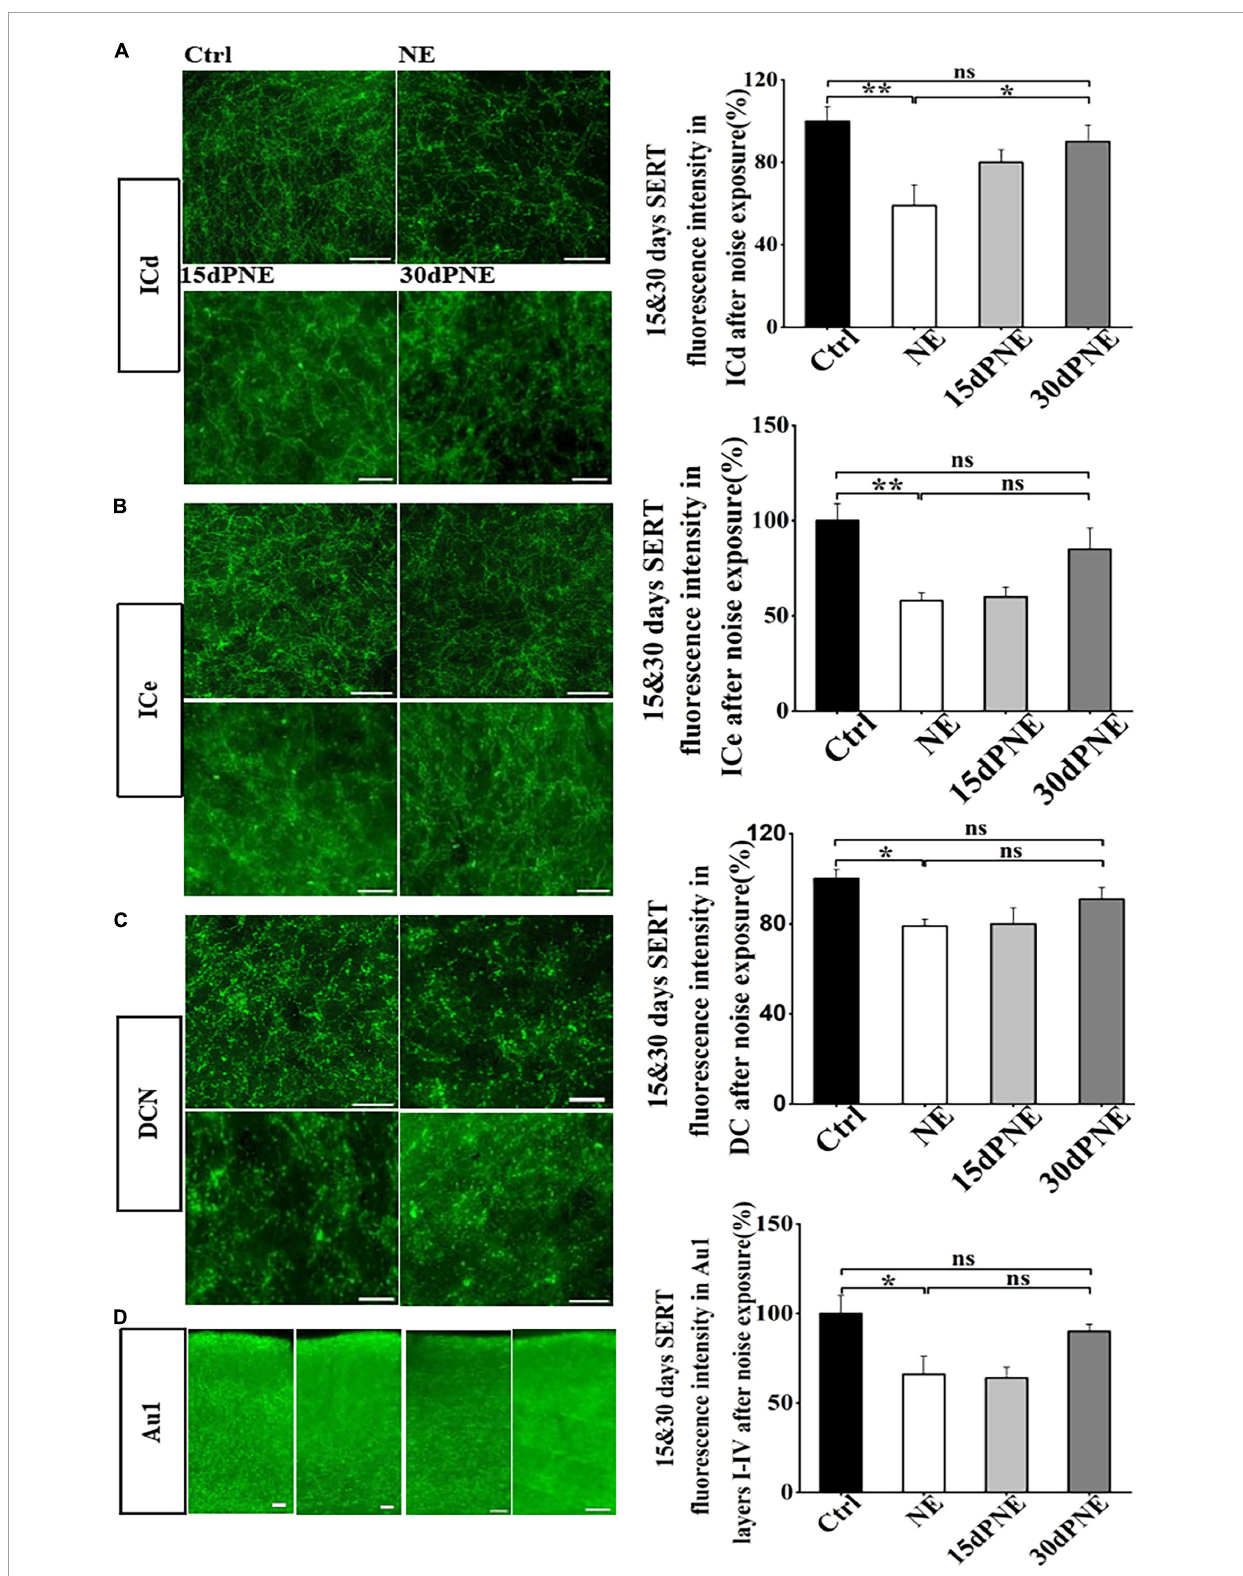
FIGURE4 Loss of SERT in some subregions recovered partially 15 and 30 days after noise exposure. (A–D) Left: Micrograph taken with a 40 × magnification show the distribution of SERT + fibers in the DCN, ICd, ICe, and Au1 layers I-IV. Right: Bar graphs represent the percentage of the SERT immunofluorescence intensity in these subregions between NE, 15dPNE, 30dPNE groups and the Ctrl group. Values are mean ± SE, data was analyzed by Tukey’s test following one-way ANOVA. Ctrl group n = 7; NE group n = 7; 15dPNE group n = 7; 30dPNE group n = 7. Statistical difference is represented as * p < 0.05, ** p < 0.01, and *** p <